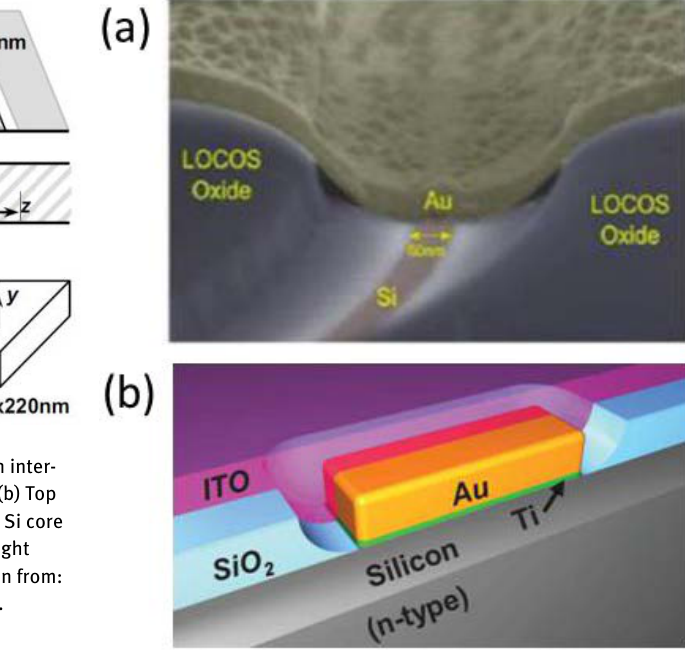
Figure 11: (a) SEM micrograph of the Schottky contact of an on-chip nanoscale silicon surface-plasmon Schottky photodetector. (b) Schematic illustration of an active optical photodetector consisting of an Au resonant antenna on a n-type silicon substrate. Figures with reprint permission from: (a) Ref. [21] ©2011 American Chemical Society, and (b) Ref. [224] ©2011